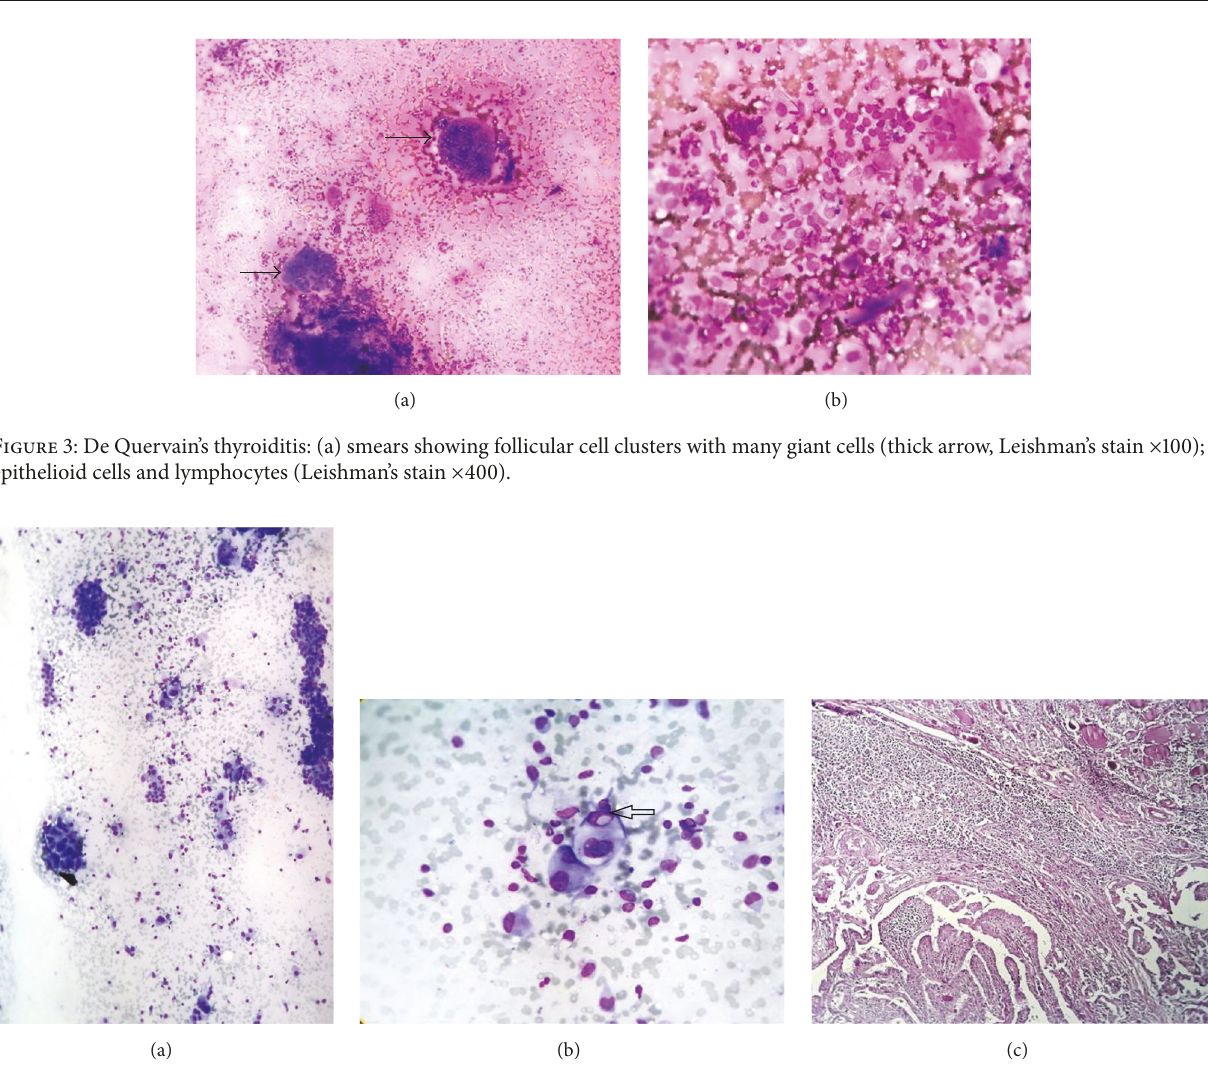
Figure 4: Hashimoto’s thyroiditis with thyroid carcinoma: (a) smears showing many large atypical cells (Leishman’s stain × 400); (b) atypical follicular cells with intranuclear cytoplasmic inclusion; (c) tissue section showing papillary thyroid carcinoma (Haematoxylin & Eosin ×